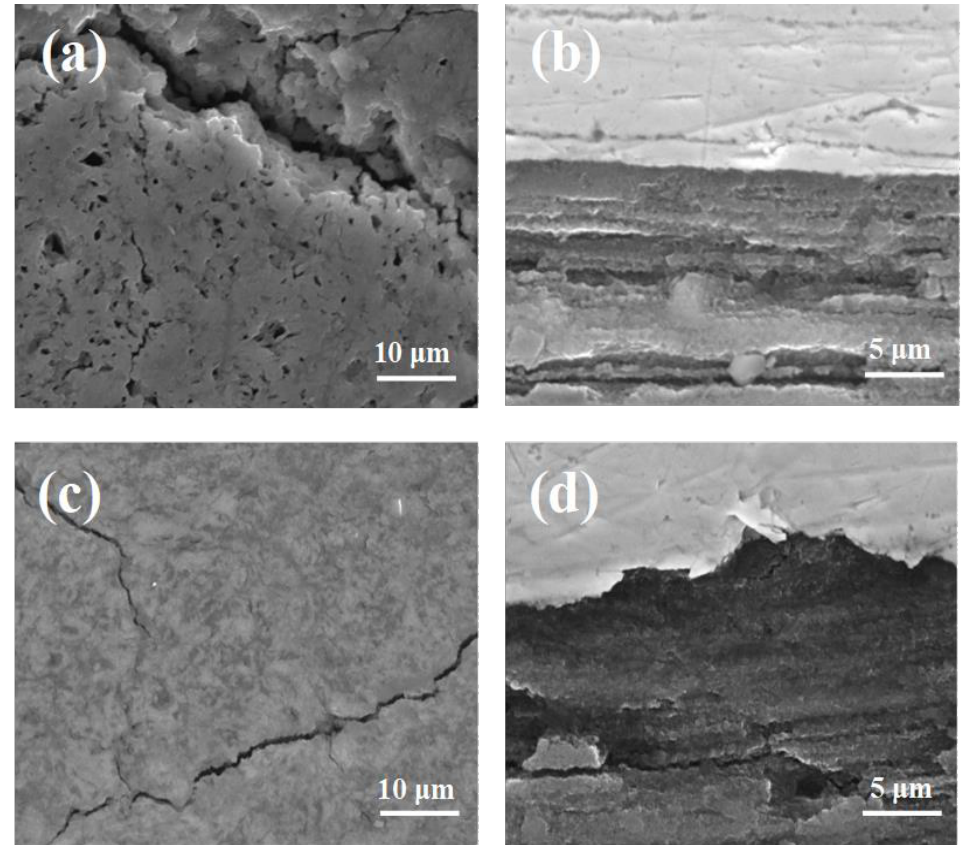
Figure 4. SEM images of 10% SiC-doped MgB 2 wires with a 0.63 mm diameter: ( a ) cross-section and ( b ) longitudinal section for sample J (0.1 MPa and 700 °C) and ( c ) cross-section and ( d ) longitudinal section for sample K (1 GPa and 700 °C). The metal sheath is the Nb barrier.